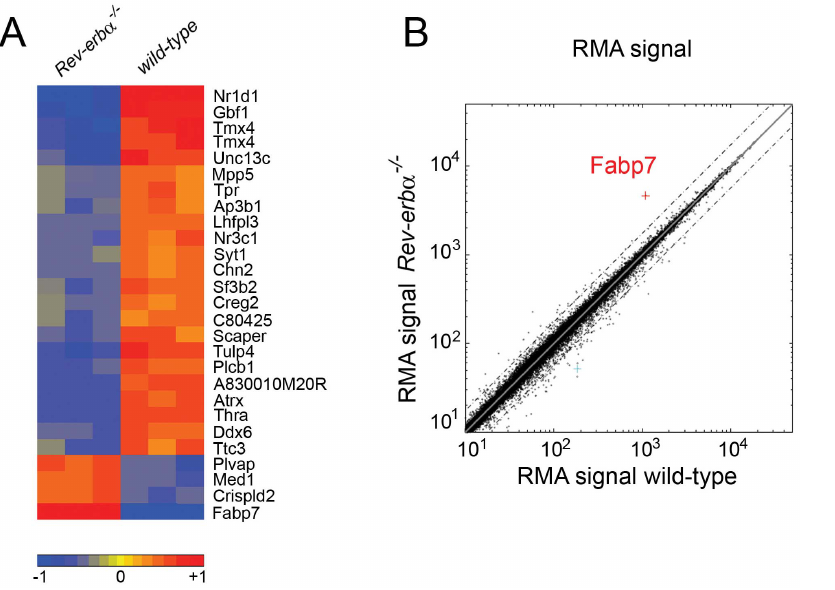
Figure 1. Genome wide expression profiling of wild-type and Rev-erb a 2 / 2 tissue from suprachiasmatic nuclei (SCN). ( A ) The strongest up- and down-regulated genes are displayed with red color marking the up-regulated genes and blue the down-regulated genes. The heat map is a selection of genes from the array based on p , 0.01 (t-test) and an absolute fold change greater than 1.75. The color code is based on the log2 value of the fold change of the RMA values. The three columns per genotype represent the individual experiments (n=3). ( B ) Plot of the RMA signals from wild-type versus Rev-erb a 2 / 2 SCN reveals Fabp7 as the most up-regulated gene in Rev-erb a 2 / 2 mice (dotted lines represent 2 fold changes).